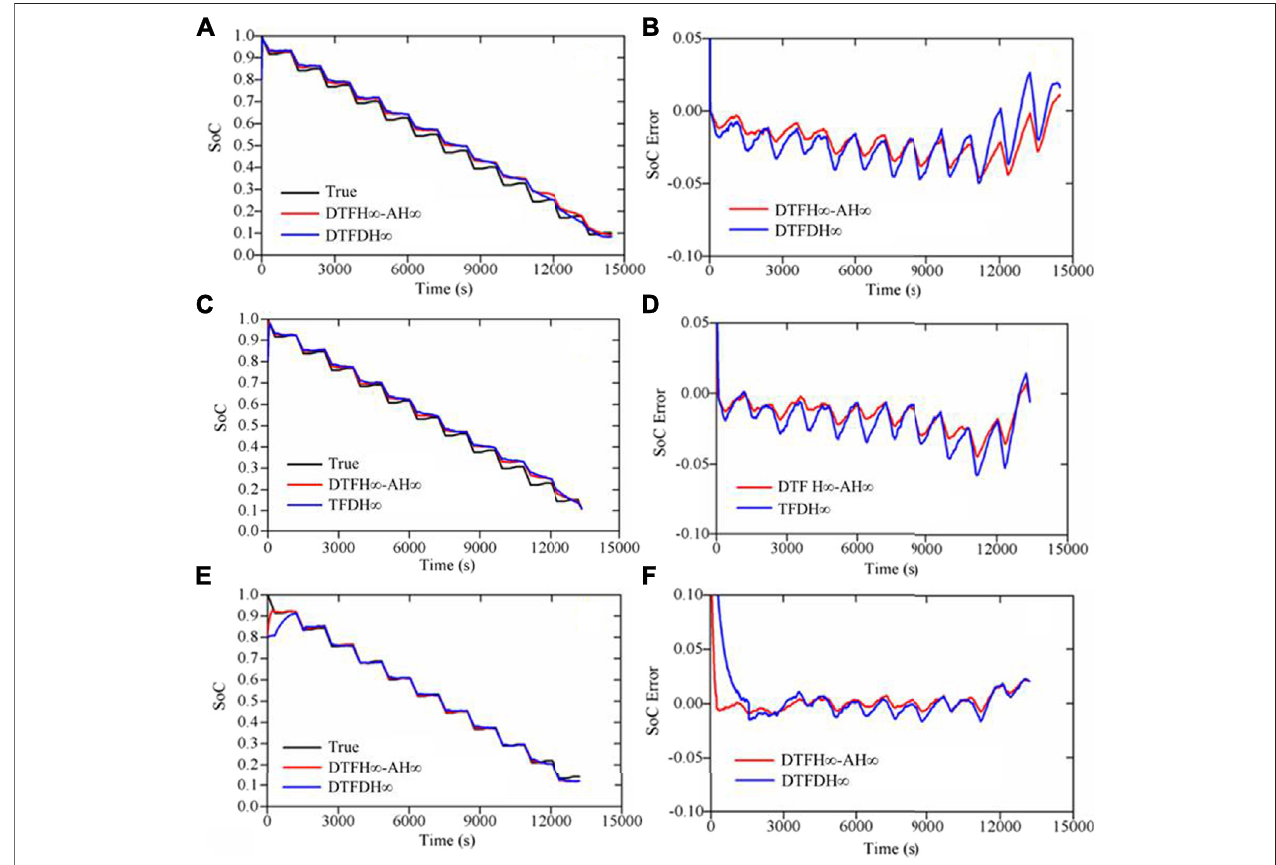
FIGURE 8 | Comparison results for the cell tested at three temperatures. (A) Estimated SoCs at 20 ° C; (B) estimation errors at 20 ° C; (C) estimated SoCs at 10 ° C; (D) estimation errors at 10 ° C; (E) estimated SoCs at 0 ° C; (F) estimation errors at 0 ° C.